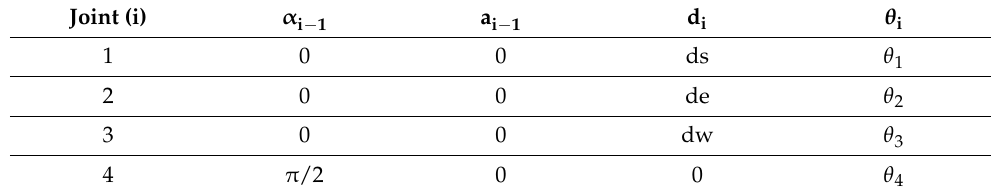
Table 3. Modified Denavit–Hartenberg